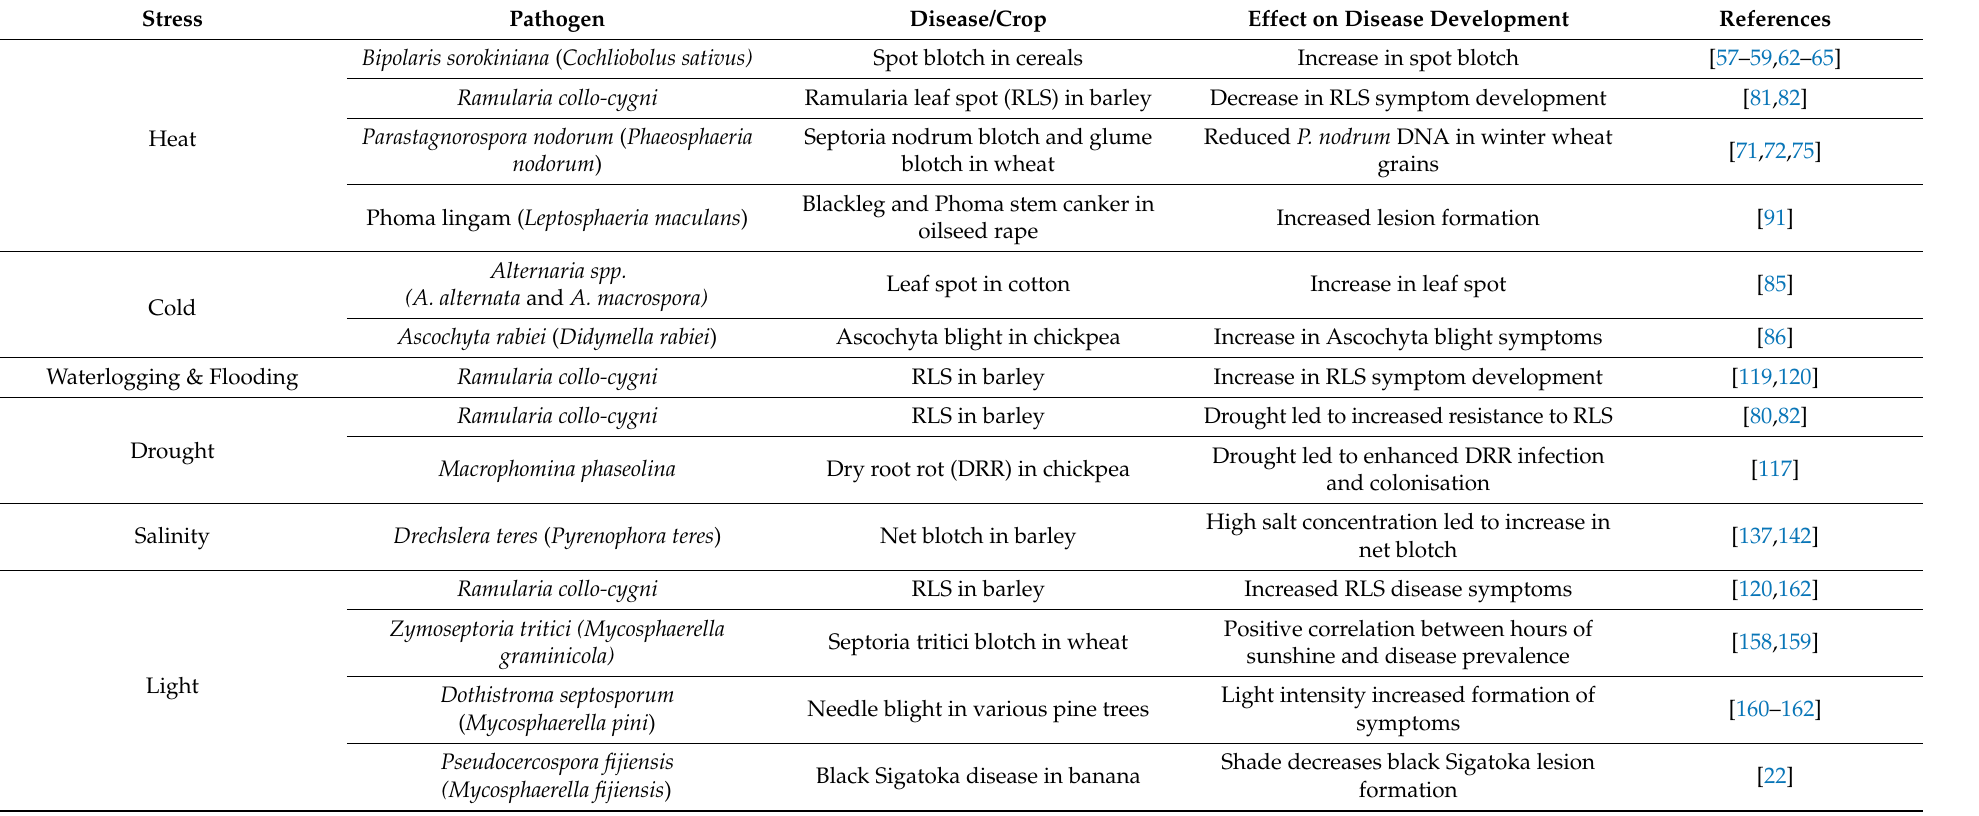
Table 1. Effect of selected abiotic stresses on plant-pathogenic Dothideomycete